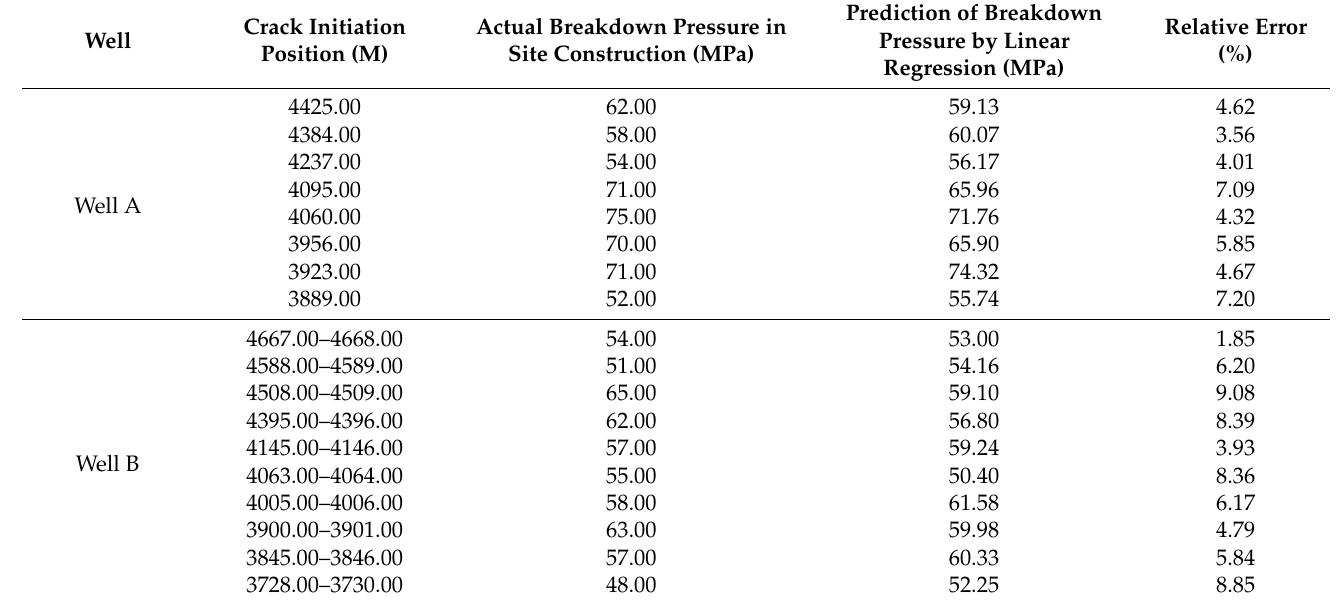
Table 5. Error analysis between actual breakdown pressure at different initiation positions and breakdown pressure predicted by linear regression.